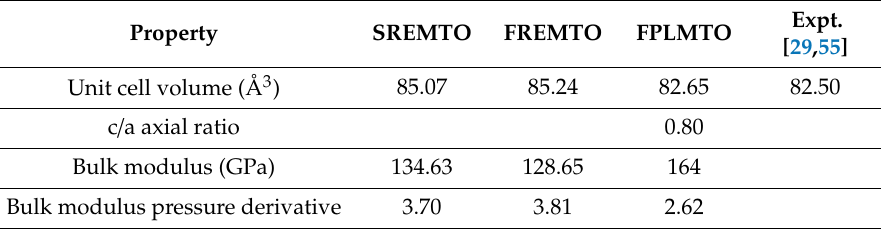
FPLMTO: full-potential linear mu ffi n-tin